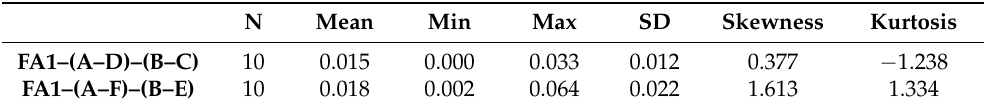
Table 6. Basic statistics of the asymmetry index of bilateral measurements of the maxillary alveolar process—control